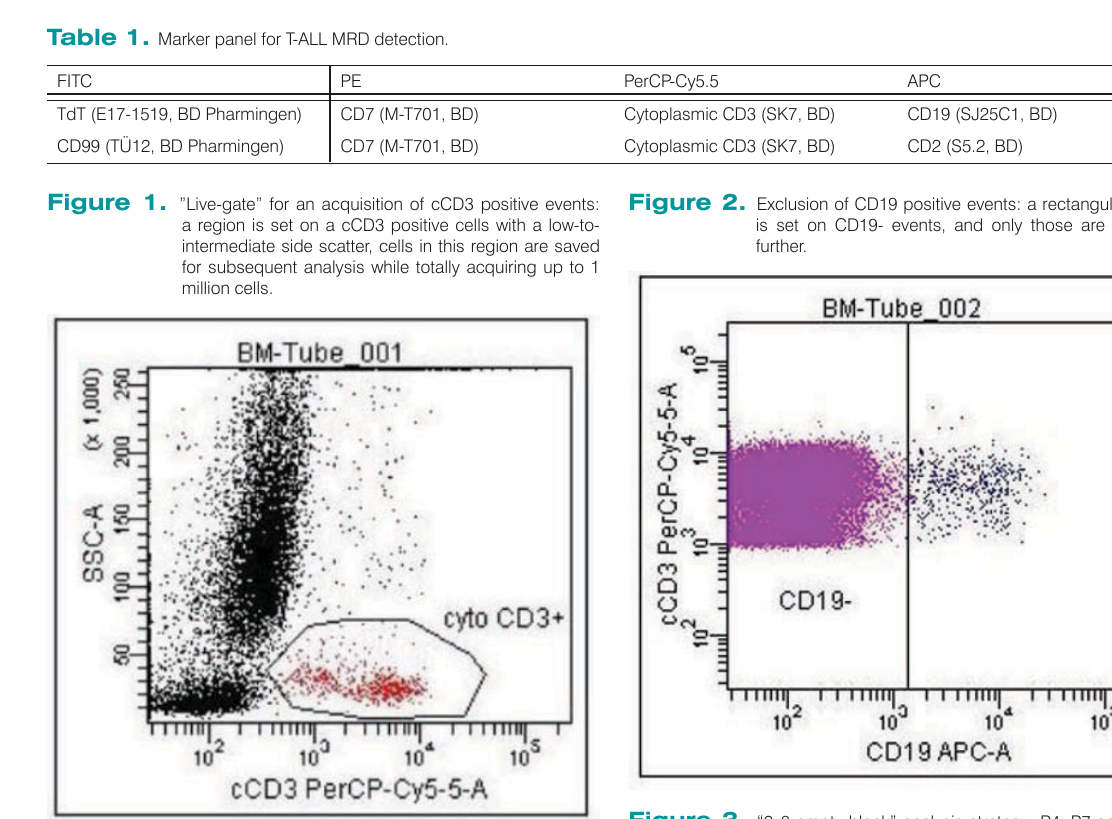
Figure 3. “2x3 empty block” analysis strategy: P4, P7 and P5 are blocks where normal T-cells can be found; P6 and P9 are blocks definitive for T-lymphoblasts; and P8 is an empty block, but T-lymphoblasts are not usually located here. In this case most T-lymphoblasts are located in block